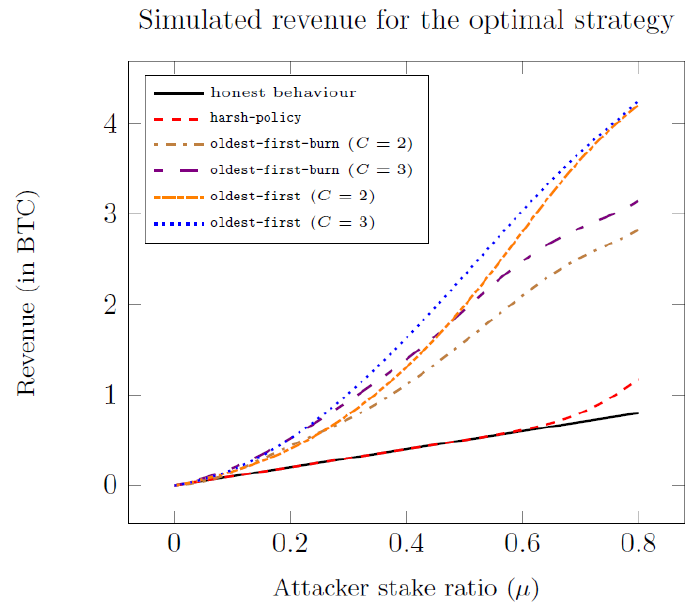
Figure 2. We simulated the revenue of an adversary M who participates in subchains of length 100 and uses the optimal strategy. Each curve represents the revenue of M as µ increases, and for a different refund policy. We fixed the protocol parameter as follows: f = 0.01, r = 0.03, and v = 0.1, all conventionally expressed in